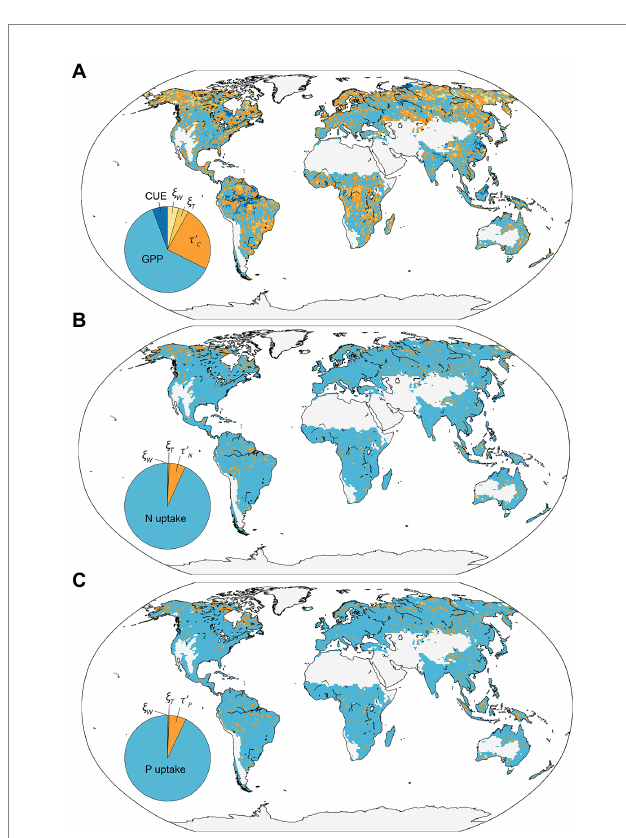
FIGURE 6 The global pattern of the dominant variable for the variation in simulated land carbon (A) , nitrogen (B) , and phosphorus (C) storage among three simulations. The insert panels indicate the proportion of each traceable components in global vegetated grids. GPP, gross primary productivity, CUE, carbon use efficiency; T ξ , temperature scalars; W ξ , water scalars; C τ ′ , baseline C residence time; N τ ′ , baseline N residence time; P τ ′ , baseline P residence